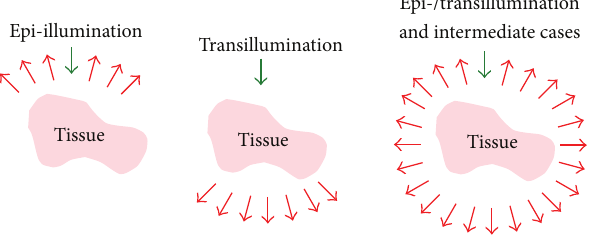
Figure 5: Multiview illumination and detection